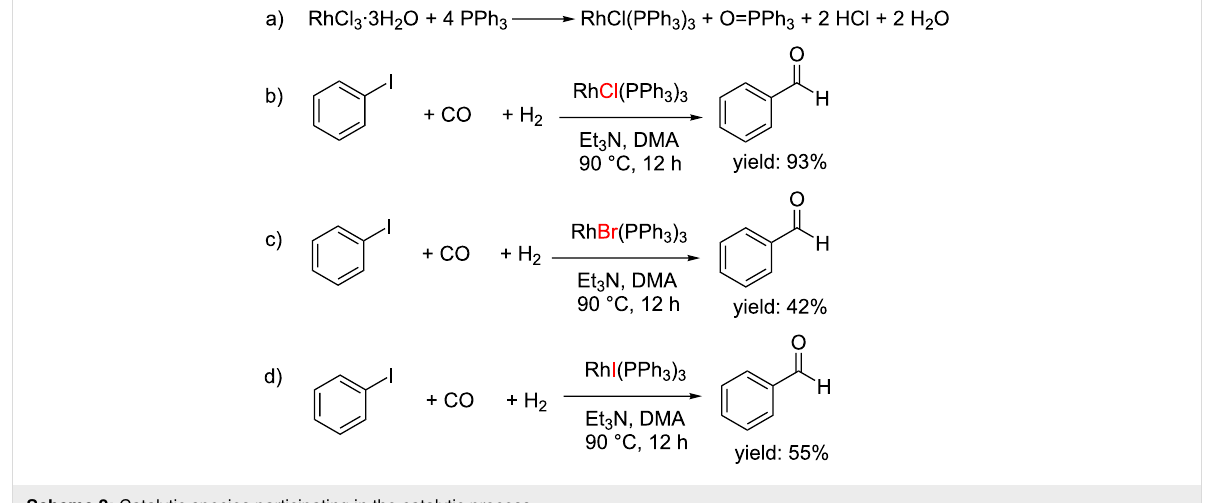
Scheme 2: Catalytic species participating in the catalytic process.